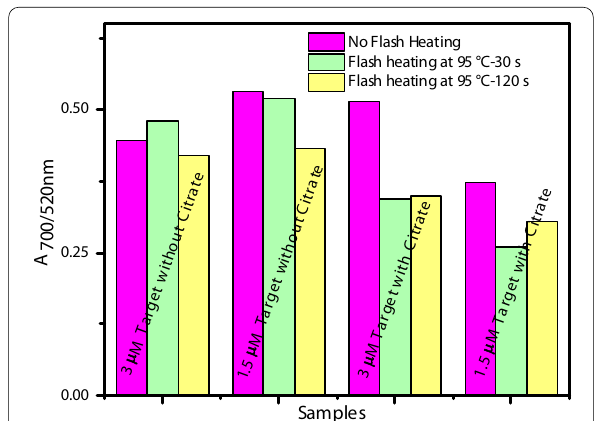
Fig. 3 Plot depicting the A 700/520 ratiometric values of selected samples as a function of different hybridization conditions